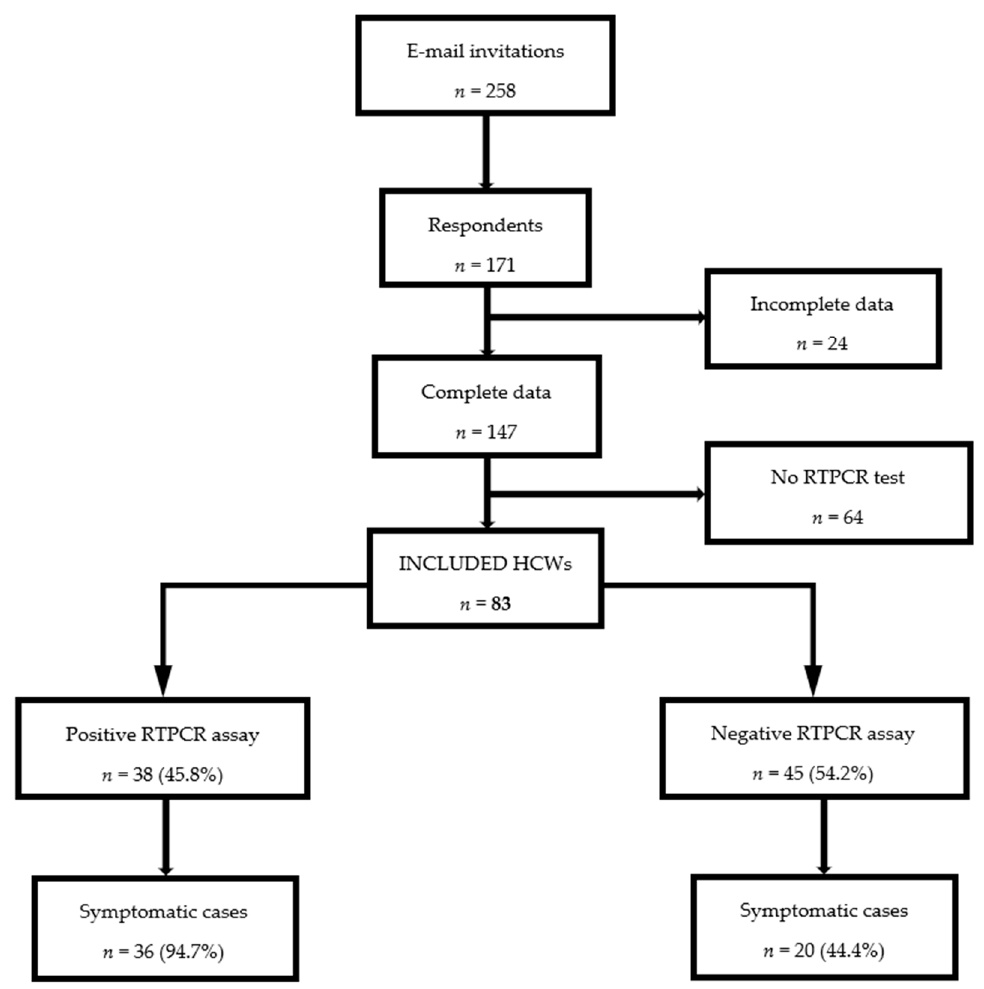
Figure 1. Study flow chart (RTPCR: reverse transcription polymerase chain reaction, HCWs: healthcare workers).